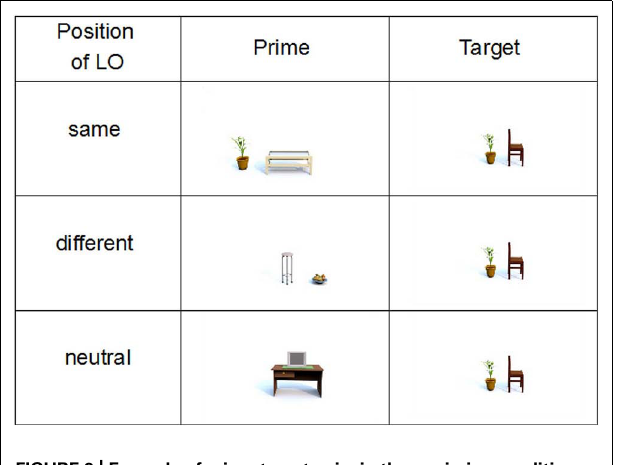
FIGURE 3 | Example of prime-target pairs in three priming conditions. FIGURE 4 | Role change between